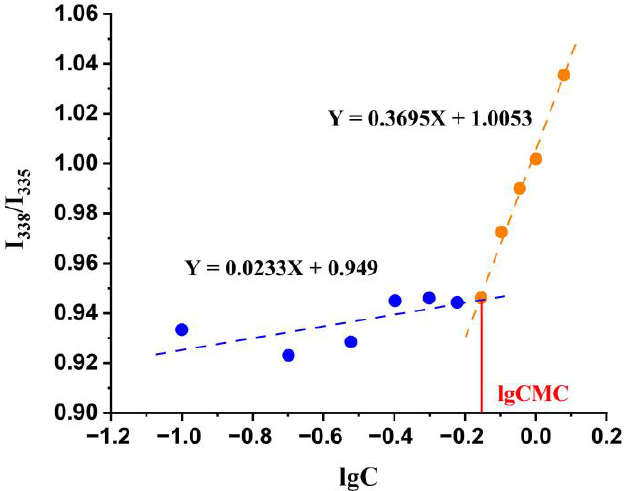
Figure 2. CMC determination of DG by the pyrene fluorescent probe method.